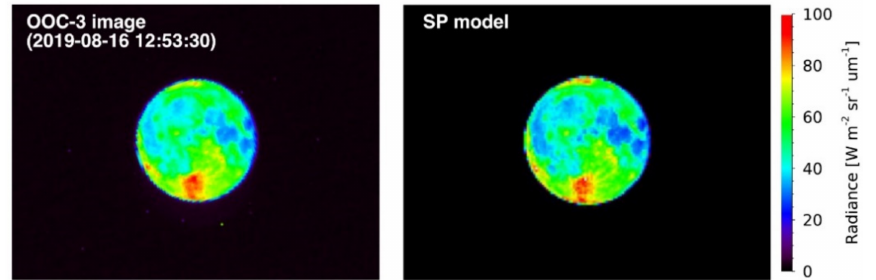
Figure 4. Moon images captured by the OOC − 3 (555 nm) band ( left ) and simulated by the SP model ( right ). Both images are cropped to 165 × 124 pixels, and the observation image is